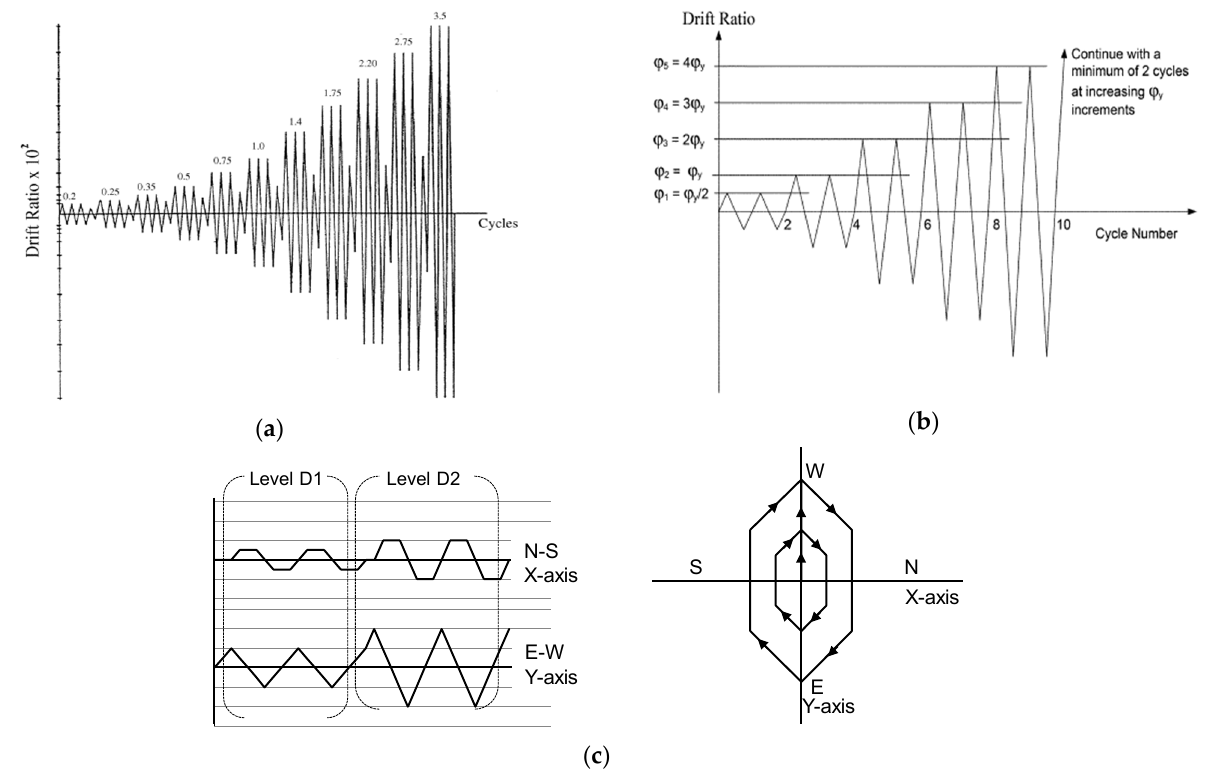
Figure 2. Recommended loading protocols for seismic evaluation in guidelines: ( a ) ACI-374.1-05 [27] loading sequence, ( b ) ACI-374.2-R13 [29] recommendation, ( c ) bidirectional loading sequence as per ACI-374.2-R13 [29].